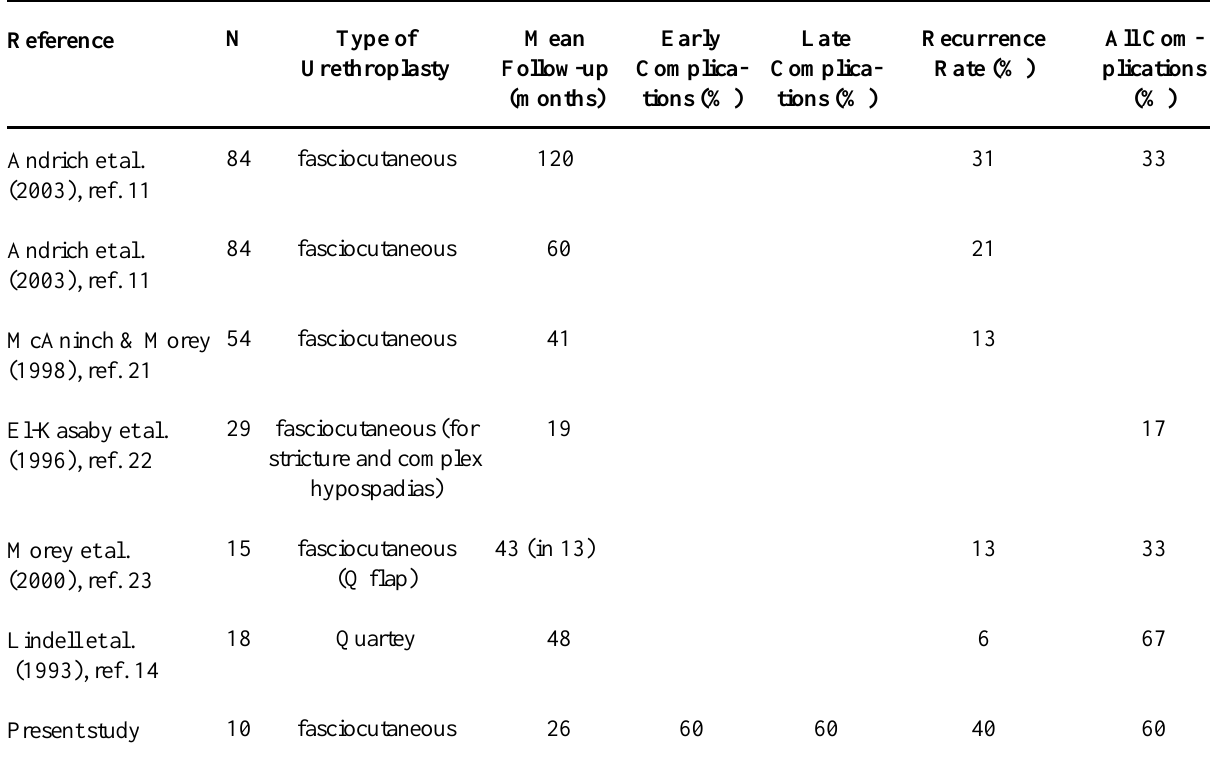
Table 11 – Reported complication post fasciocutaneous